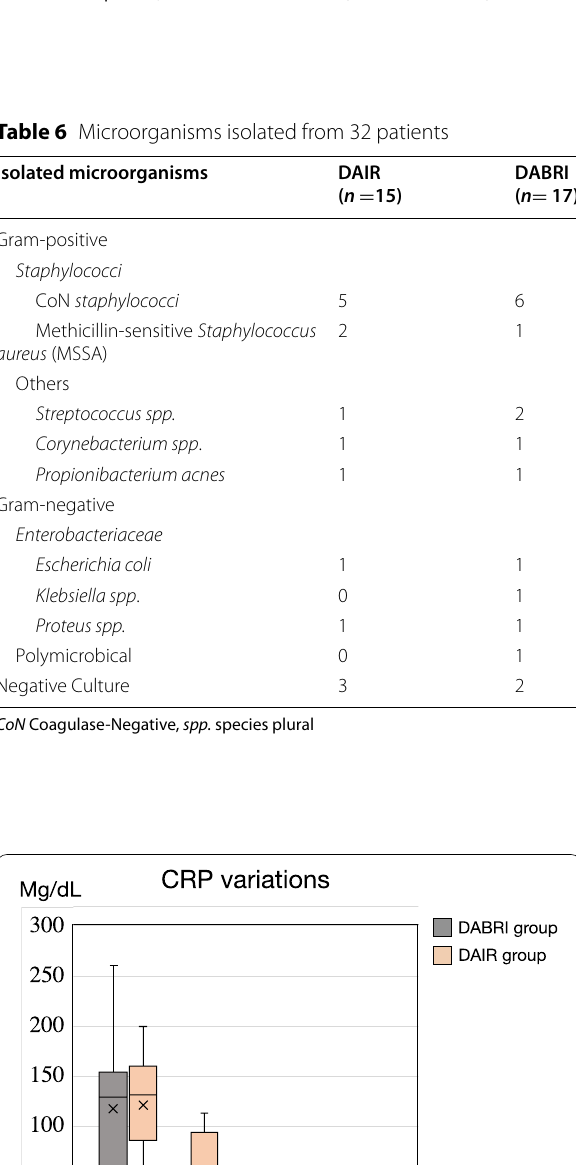
CRP C-reactive protein; data are shown as mean (standard deviation).